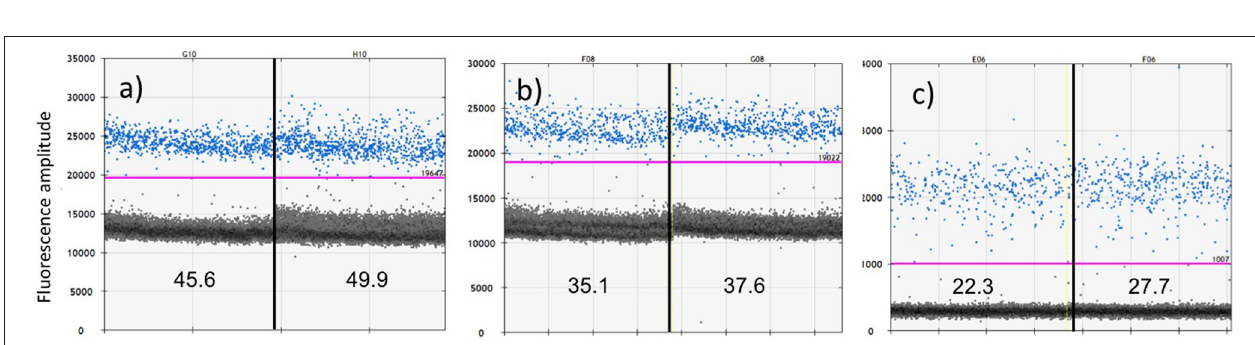
FIGURE 2 | Locations of PCR primers and a molecular probe in the mtDNA control region of the killer whale. The probe assay amplified a 246 bp fragment from Oordlp5Rleft to dlp8G, using Oordlp6.5F as the probe. The EvaGreen assay amplified a 139 bp fragment from Oordlp6.5F to dlp8G. *Primer pairs used for conventional PCR.